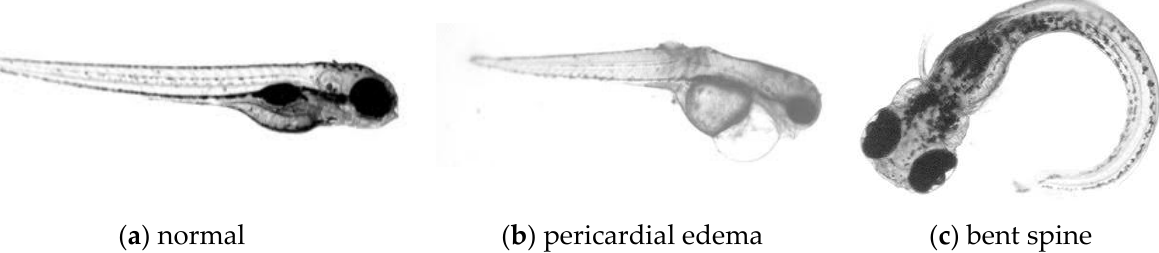
Figure 3. Representative images of zebrafish embryos ( a ) normal development; ( b ) pericardial edema and yolk-sac edema; ( c ) bent spine.